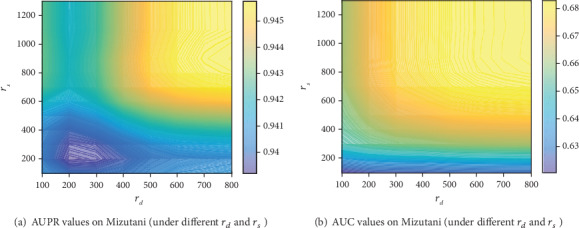
The AUC and AUPR values (under different rd and rs).